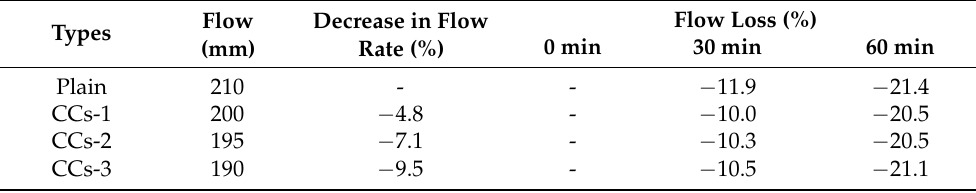
Table 4. Fresh state characteristics of the cement mortars.